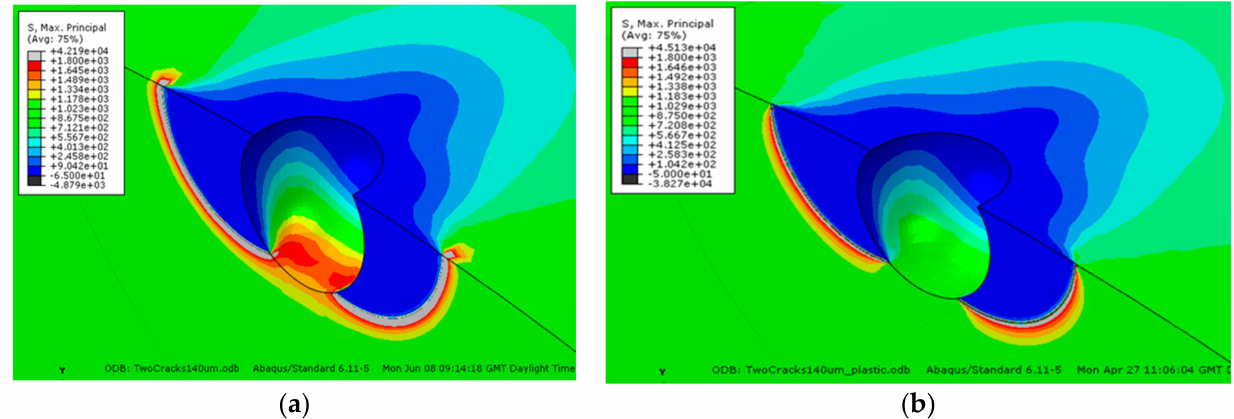
Figure 6. Stress distribution (in MPa) around 150 µ m deep pit and 140 µ m deep crack calculated assuming ( a ) pure elastic conditions, ( b ) elastic-plastic conditions. Remote stress applied is 90% σ 0.2 [22].